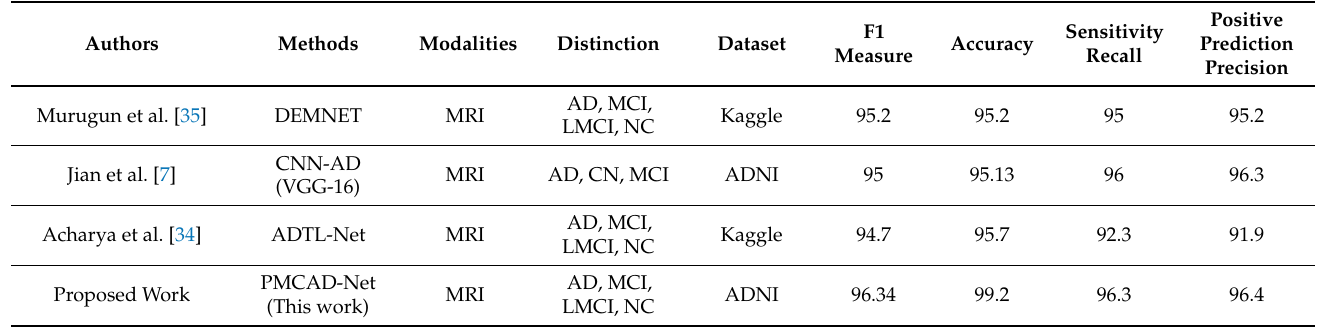
Table 4. Comparison of the proposed work with various state-of-the-art approaches in terms of evaluation metrics.